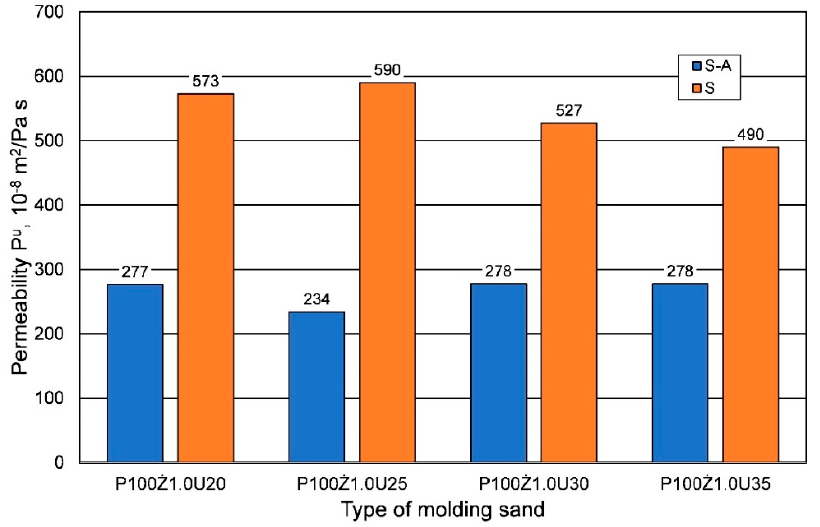
Figure 11. Permeability P u of hardened molding sand (24 h) prepared on the basis of fresh chromite sand, depending on weather conditions, for different amounts of hardener added.